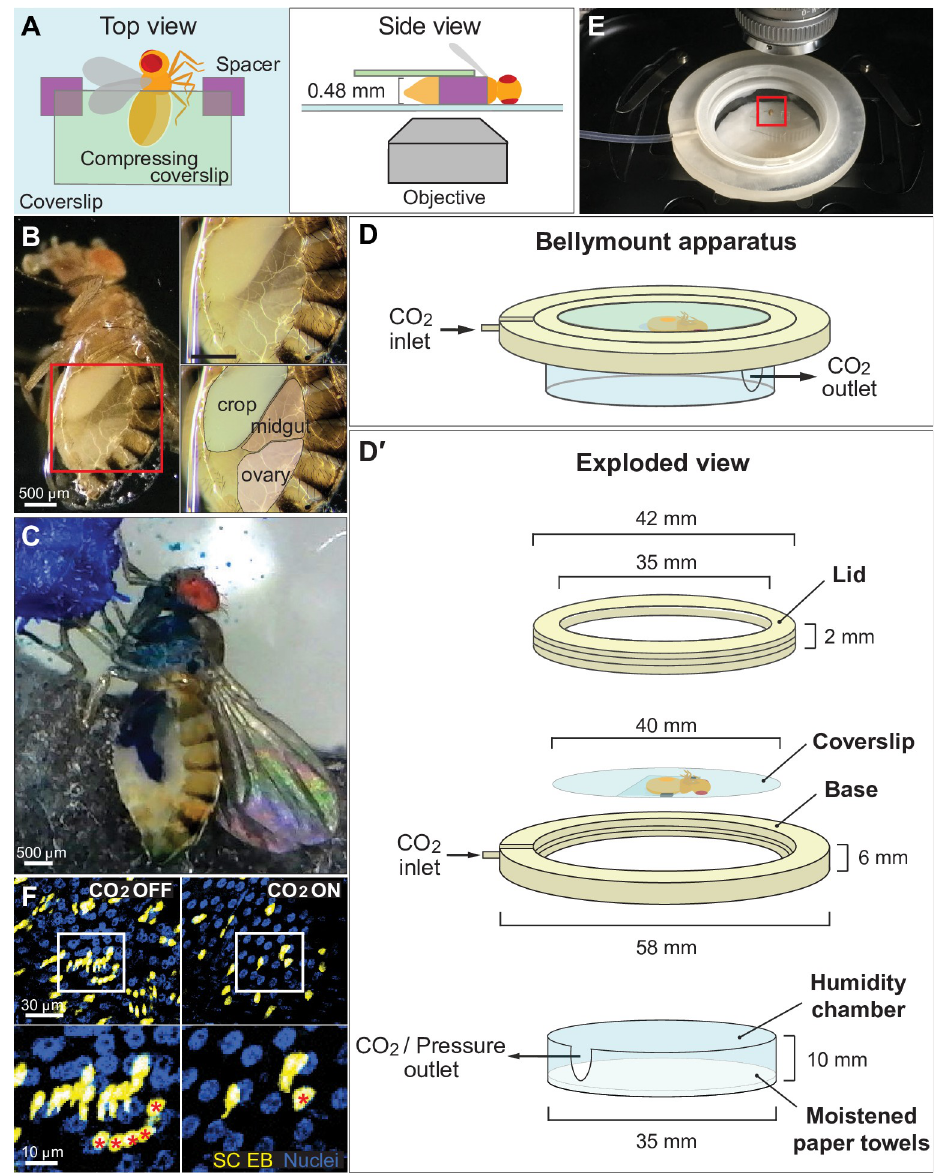
Fig 1. The Bellymount platform enables intravital imaging of the adult Drosophila abdomen. (A) Cartoons of Bellymounted animal. Top and side views are shown. The cuticle of the ventrolateral abdomen is glued to the bottom coverslip. To maximize contact between the cuticle and the glue, a second, smaller coverslip gently compresses the abdomen. (B) Underside view of a Bellymounted adult female. Gluing caused the ventral cuticle to become light transparent. The edge of the glue patch appeared as a refractive line around the abdomen. Right panels are close-ups of boxed region in left panel. (C) Bellymounted animals ingest nutrients, undergo GI transit, and defecate. As a mounted animal ingested blue-colored sugar water, its midgut gradually became colored blue. Image shows a single time point from S3 Movie. (D) Cartoon of Bellymount apparatus for delivery of CO 2 anesthesia during confocal imaging. Isometric drawing shows assembled (D) and exploded (D 0 ) configurations. The coverslip with the glued animal sits inside the base of the apparatus. CO 2 flows through the indicated ports. CAD files for 3D printing of the lid and base are provided as S1 and S2 Files. See also S2 Fig. (E) Bellymount apparatus positioned for imaging on an upright microscope. Red box shows the location of the glued animal. (F) CO 2 anesthesia minimizes tissue movements during acquisition of confocal z -stacks. Without CO 2 (left), tissue movements during z -stack acquisition caused individual cells to be represented multiple times. With CO 2 (right), tissue movements were inhibited, and z -stack images were accurate. Bottom panels are close-ups of boxed regions in top panels. Red asterisks label the identical cell in images taken without and with CO 2 . Blue, nuclei; yellow, midgut stem cells and enteroblasts. Images are projections of confocal stacks. Genotype: esg > LifeActGFP; ubi-his2av :: mRFP . See S4 Movie. CAD, computer-aided design;